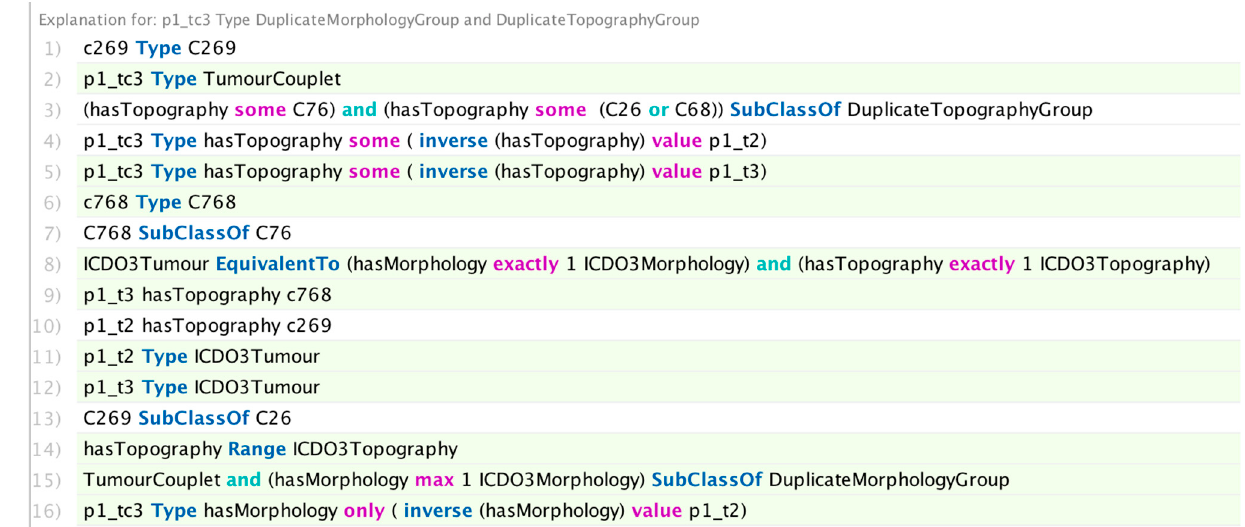
Figure 15. DL query for entities with both a duplicate topography and a duplicate morphology condition (one of the triggers for a multiple primary tumour).